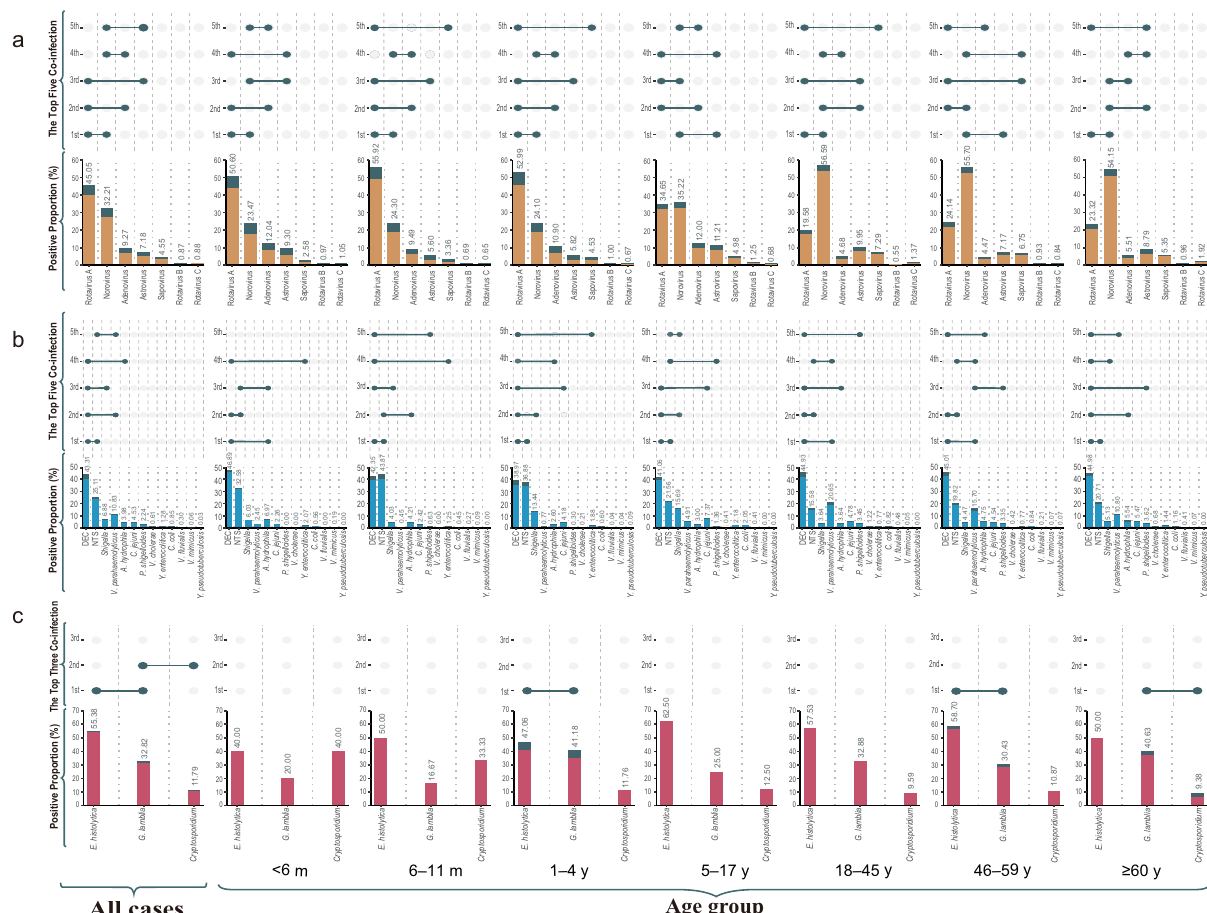
Fig. 2 Pathogen spectrum and co-infection pattern of enteropathogens in diarrhea patients by age group in the mainland of China, 2009 ‒ 2018. a The viral spectrum and co-infection pattern of 58,620 patients with acute diarrhea who had all the seven viral pathogens tested. b The bacterial spectrum and co-infection pattern of 59,384 patients with acute diarrhea who had all the 13 bacterial pathogens tested. c The parasitical spectrum and co-infection pattern of 11,167 patients with acute diarrhea who had all three parasitical pathogens tested. The proportion of each positive pathogen was noted in % and by the length of colored bars. The orange bar indicates viral mono-infection; the blue bar indicates bacterial mono-infection; the red bar indicates parasitical mono-infection; the green bar indicates co-infection. For viruses, co-infection means co-infection among viruses. For bacteria, co-infection means co- infection among bacteria. For parasites, co-infection means co-infection among parasites. DEC diarrheagenic Escherichia coli ; NTS nontyphoidal Salmonella . Source data are provided as a Source Data fi intergroup differences were consistently observed for children while an adult with mucous or bloody stool, that occurred in warm-season were probably infected with bacteria (Supplemen- tary Table 10). The spatial-temporal pattern . The geographic diversity of detection and the seasonal patterns for each pathogen were demonstrated for seven ecological regions (Fig. 5). The effect on the spatial and the seasonal pattern was explored at the sentinel city level by using four sociological and six meteorological factors (Supplementary Table 11). The daily mean temperature affected most of the detected viruses and bacteria signi fi cantly, but with different directions of effects. Incidence rate ratios (IRRs) for viruses ranged from 0.83 (95% CI: 0.82 ‒ 0.84) to 0.96 (95% CI: 0.94 ‒ 0.97), while IRRs for bacteria ranged from 1.26 (95% CI: 1.23 ‒ 1.28) to 1.70 (95% CI: 1.62 ‒ 1.78). Consistent with these effects, the viral infection exhibited a winter-spring seasonality that spanned from December – January and ending in April – May, while the bacterial infection exhibited a Summer ‒ Autumn seasonality that spanned from May to October with peaks in summer (Fig. 5). At the city level, the proportion of children signi fi cantly affected by viral infection was greater, with the IRRs ranging from 1.03 (95%